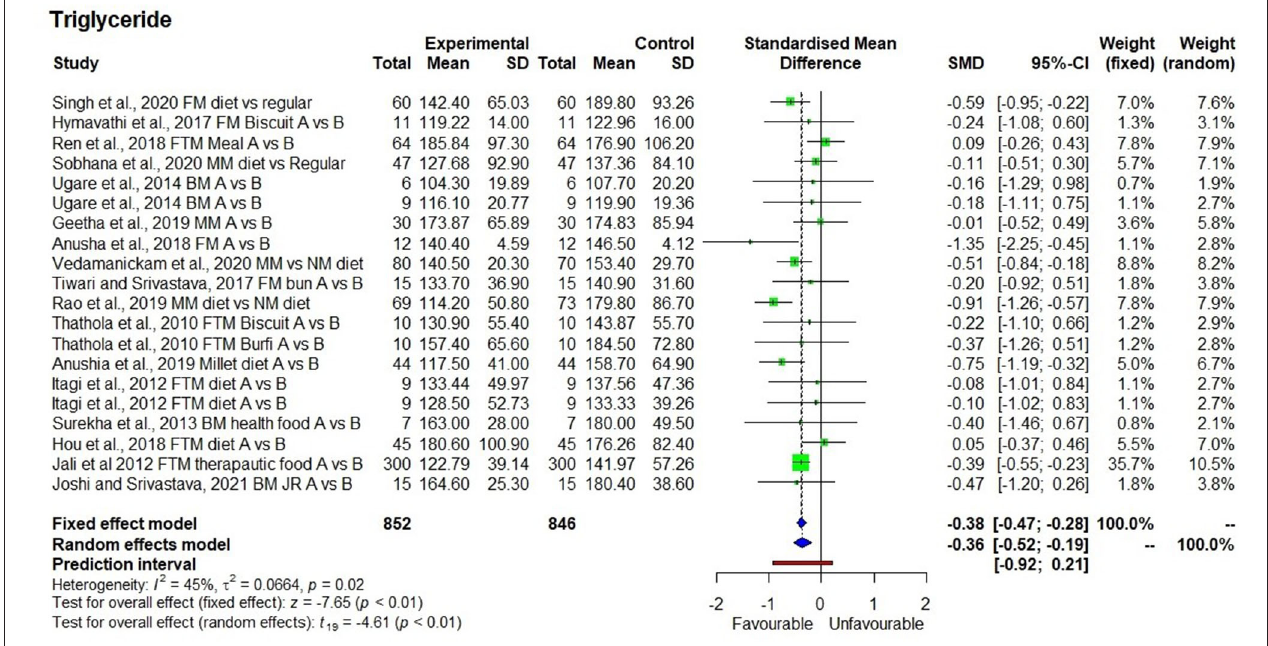
FIGURE 3 | Effect of consuming millets on triacylglycerol level (pre- vs. post-treatment or intervention vs. control diet).